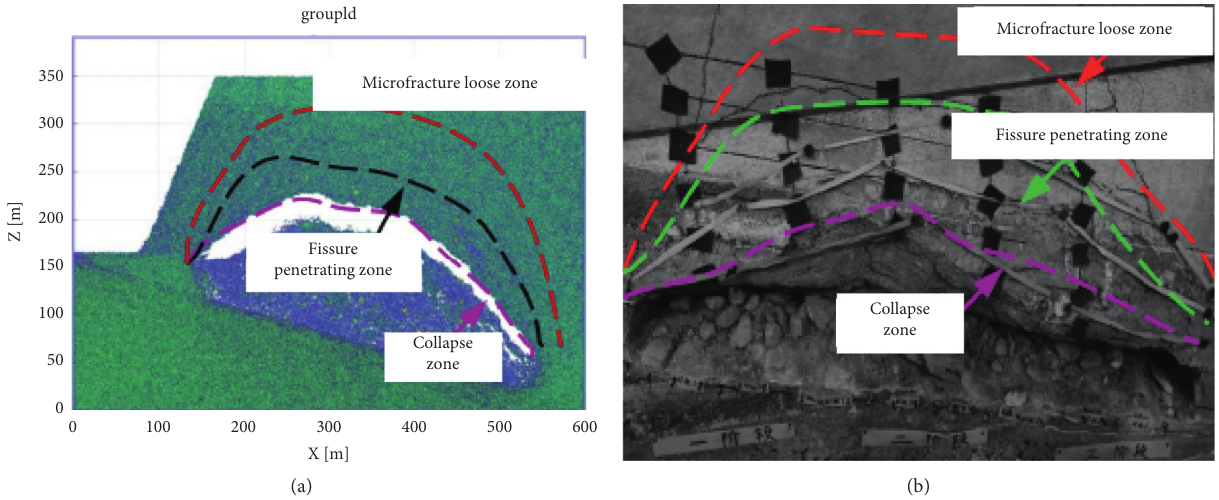
Figure 13: Comparison of collapse characteristics between numerical simulation and similar simulation under the slope height of 200m and slope angle of 65 ° .